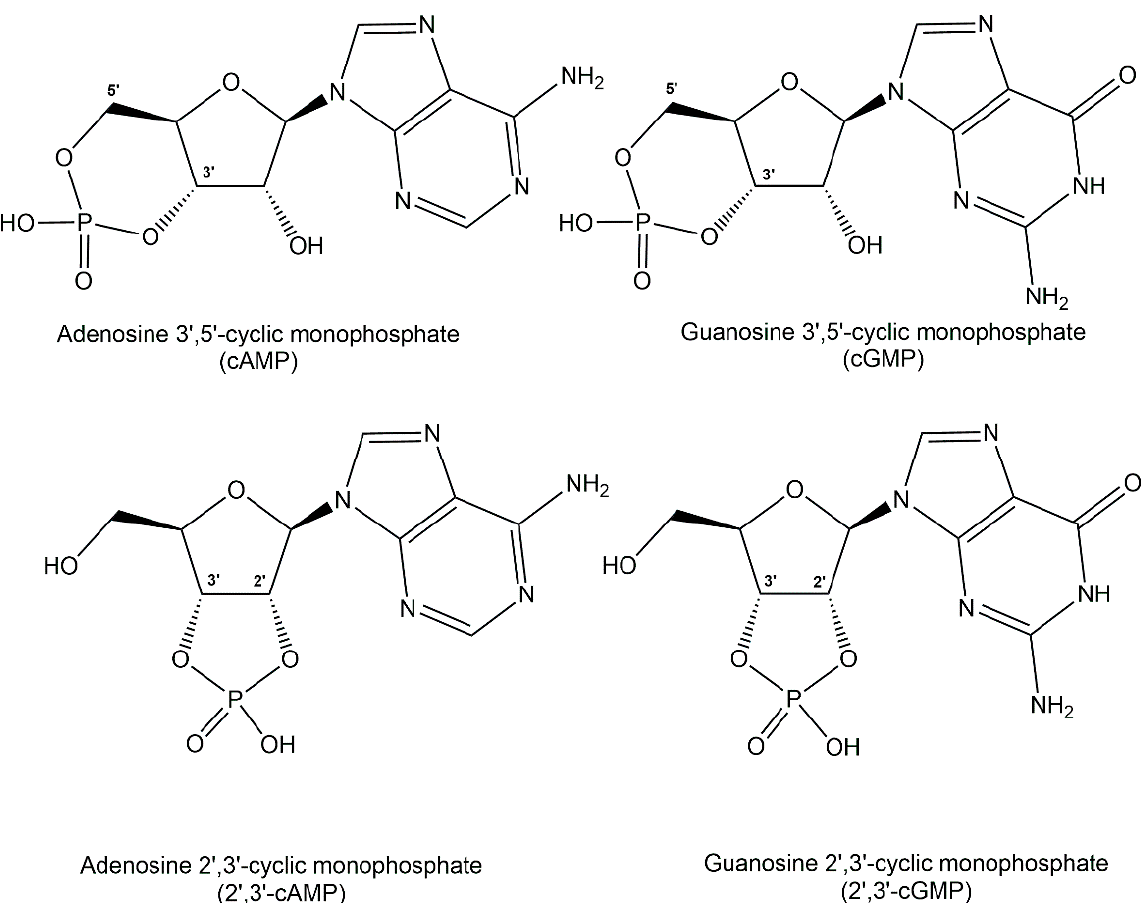
Figure 8. Structure of the nucleotide cyclic monophosphates AMP and cGMP as well as 2 ′ ,3 ′ -cAMP and 2 ′ ,3 ′ -cGMP.